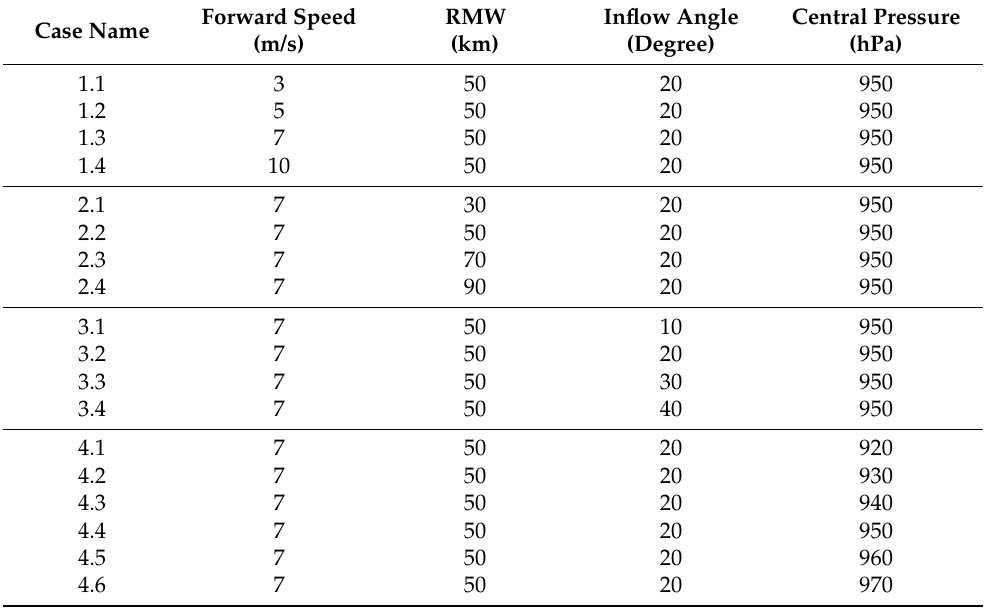
Table 2. Sensitivity experiments to explore the effect of key parameters in the wind field and pressure field on storm